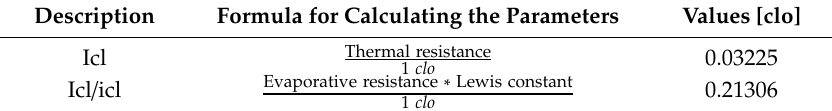
Table 4. Calculation of dimensionless parameters for defining the clothing layer.